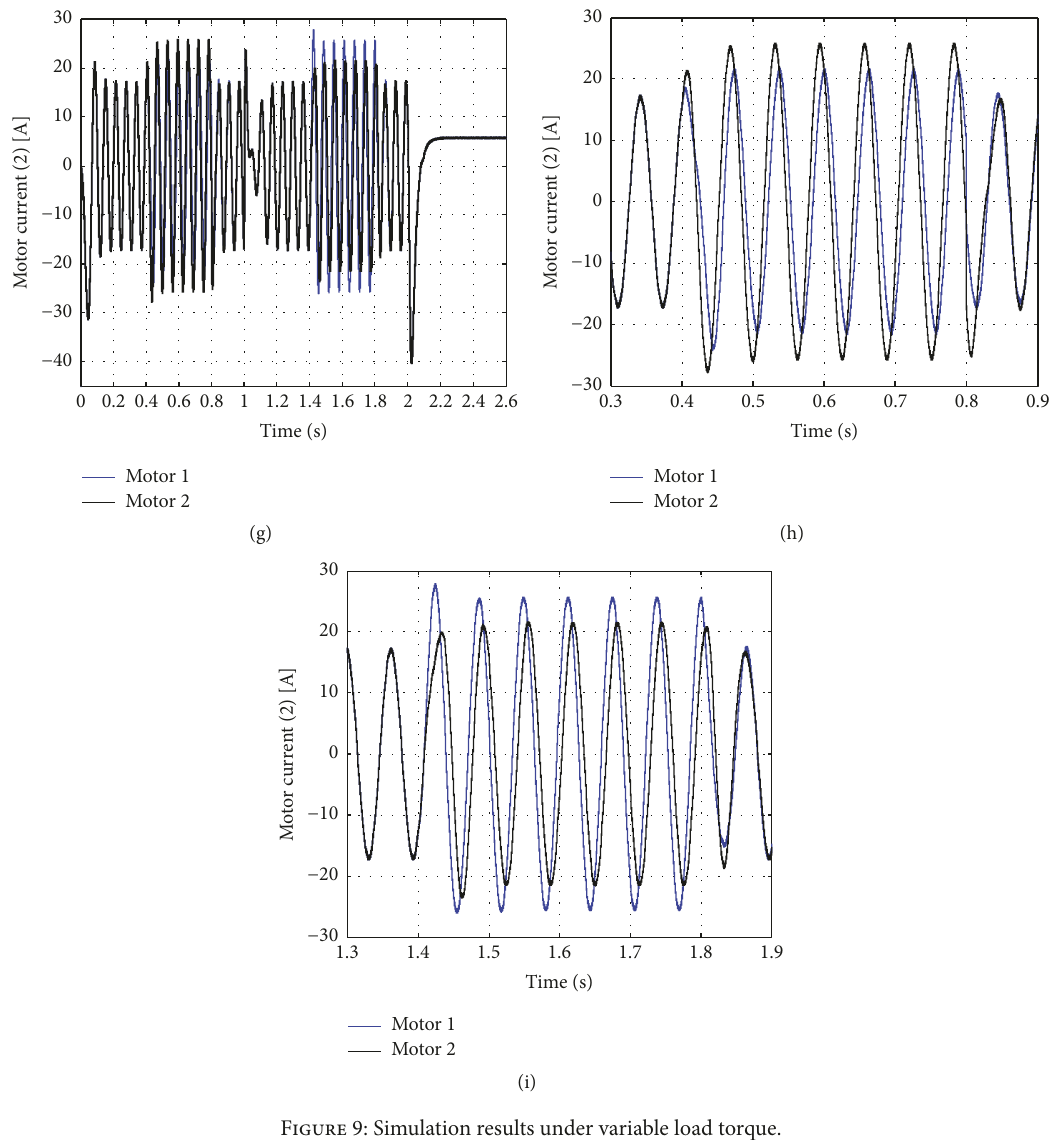
Figure 9: Simulation results under variable load torque.